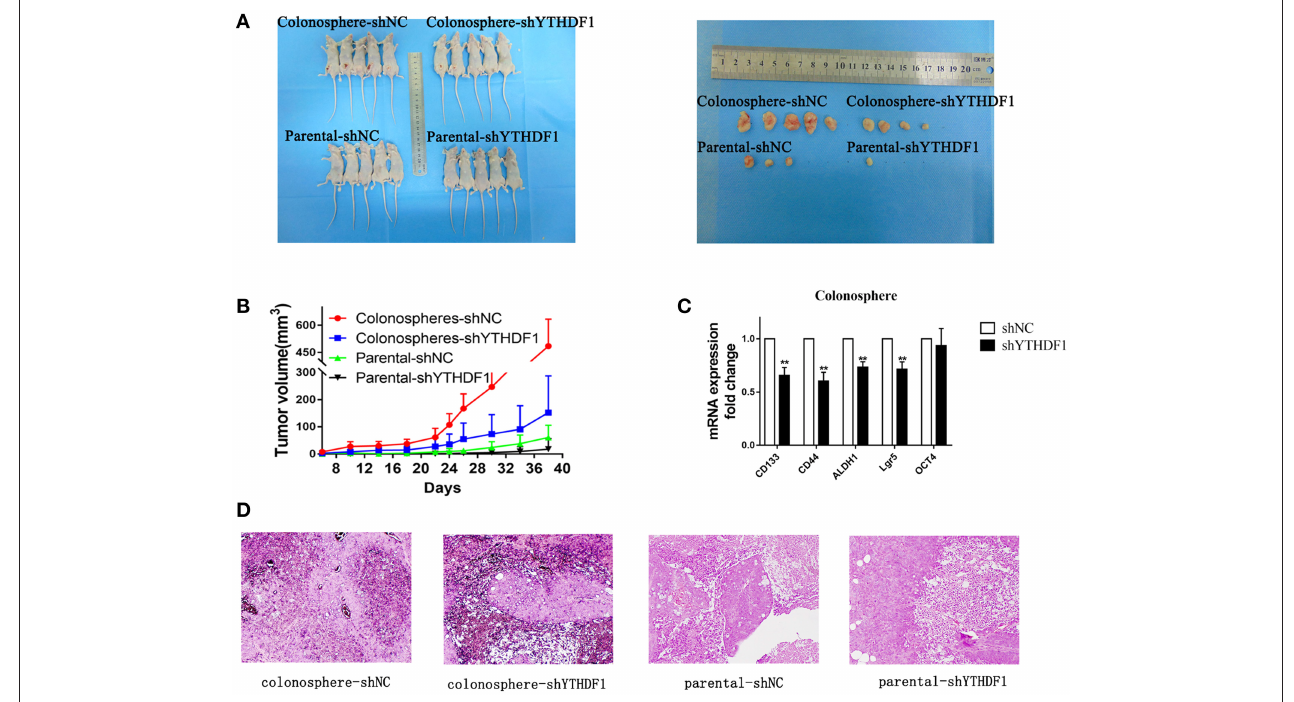
FIGURE 6 | YTHDF1 Promotes the Tumorigenicity of CRC cells in vivo . (A) Imaging of mice (left) and xenograft tumors (right) showed that YTHDF1 silencing led to smaller tumors and colonospheres formed larger tumors. (B) Tumor formation growth curves. (C) Real-time PCR analysis of stemness-related markers in colonosphere xenograft tumors with shNC or shYTHDF1 transfection. (D) Representative images of H&E staining of mouse xenograft tumors (scale bar, 100 µ m;) (** p <